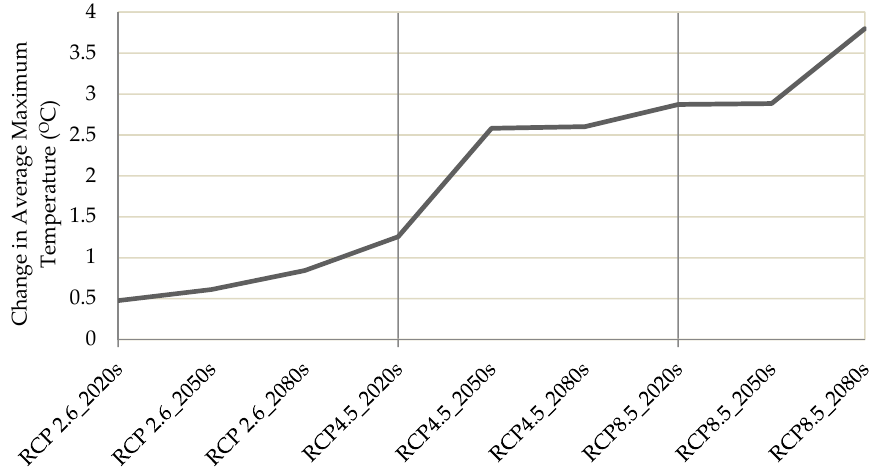
Figure 11. Change in annual average maximum temperature compared to baseline period (1961–1990).